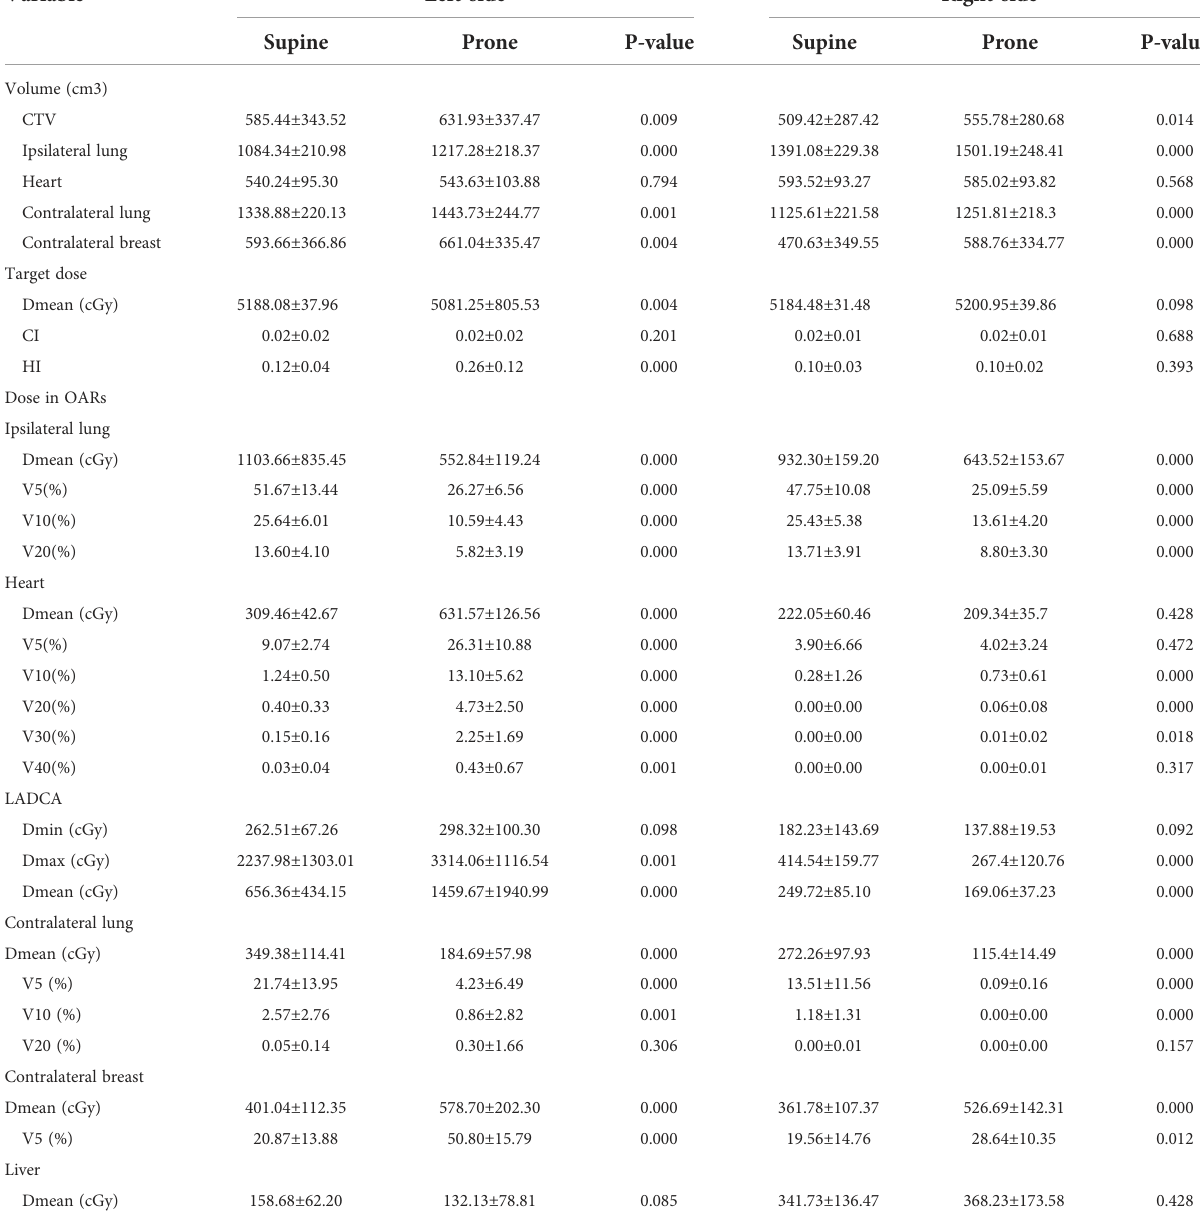
TABLE 2 Comparison between supine and prone positions for left-sided and right-sided groups. Variable